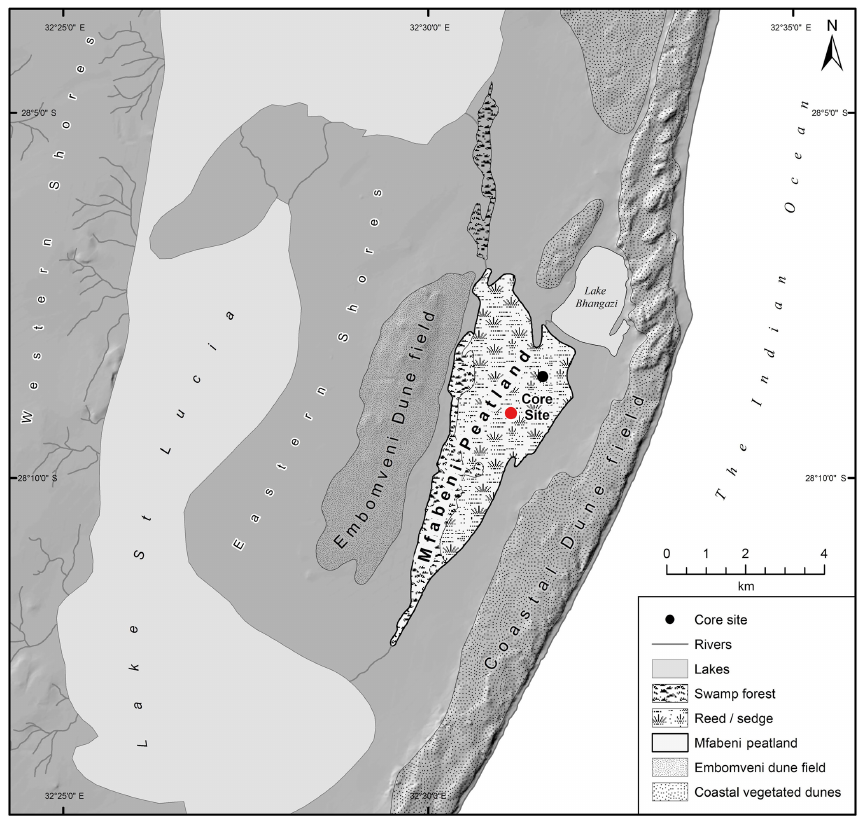
Figure 2. Mfabeni peatland and its regional geomorphological features, indicating the location of core MF4-12 (red circle, this study) and the location of core SL6 (black circle, Baker et al., 2014, 2016, 2017). Map courtesy of Brice Gijsbertsen, UKZN Cartography